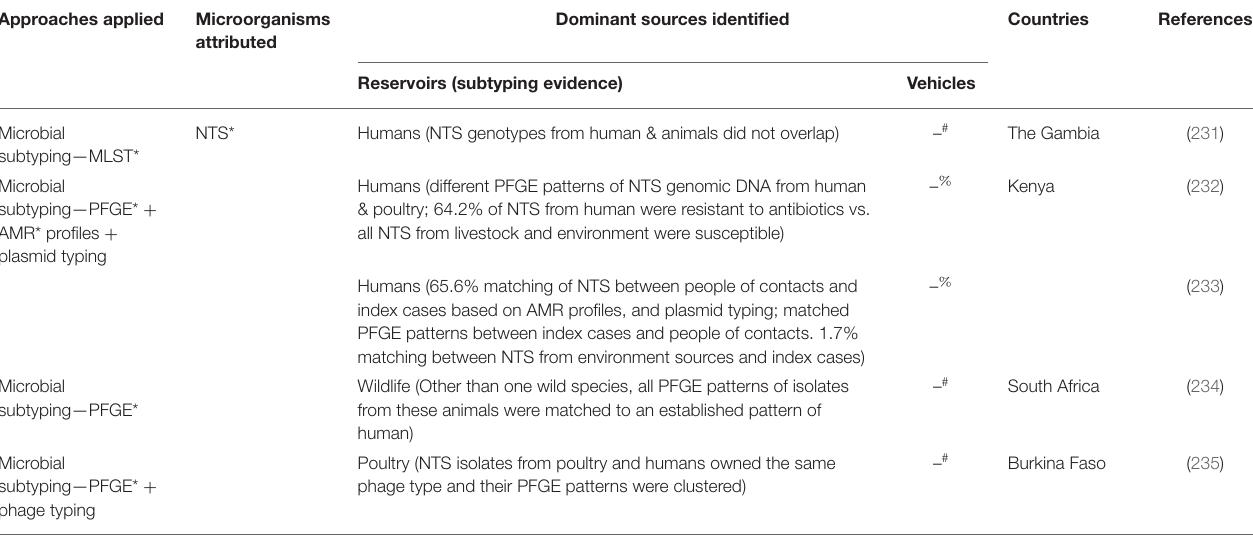
TABLE 6 | Applications of microbial subtyping in low-resource settings.